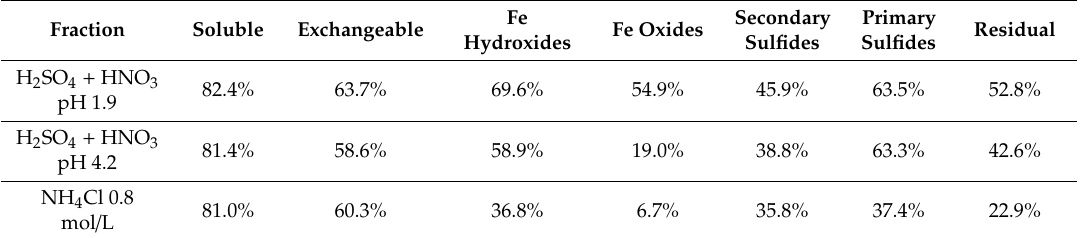
Table 4. Copper removal e ffi ciency for each fraction. Sample analyzed by the six-fraction procedure. Fraction Soluble H 2 SO 4 + HNO 3 pH 1.9 H 2 SO 4 + HNO 3 pH 4.2